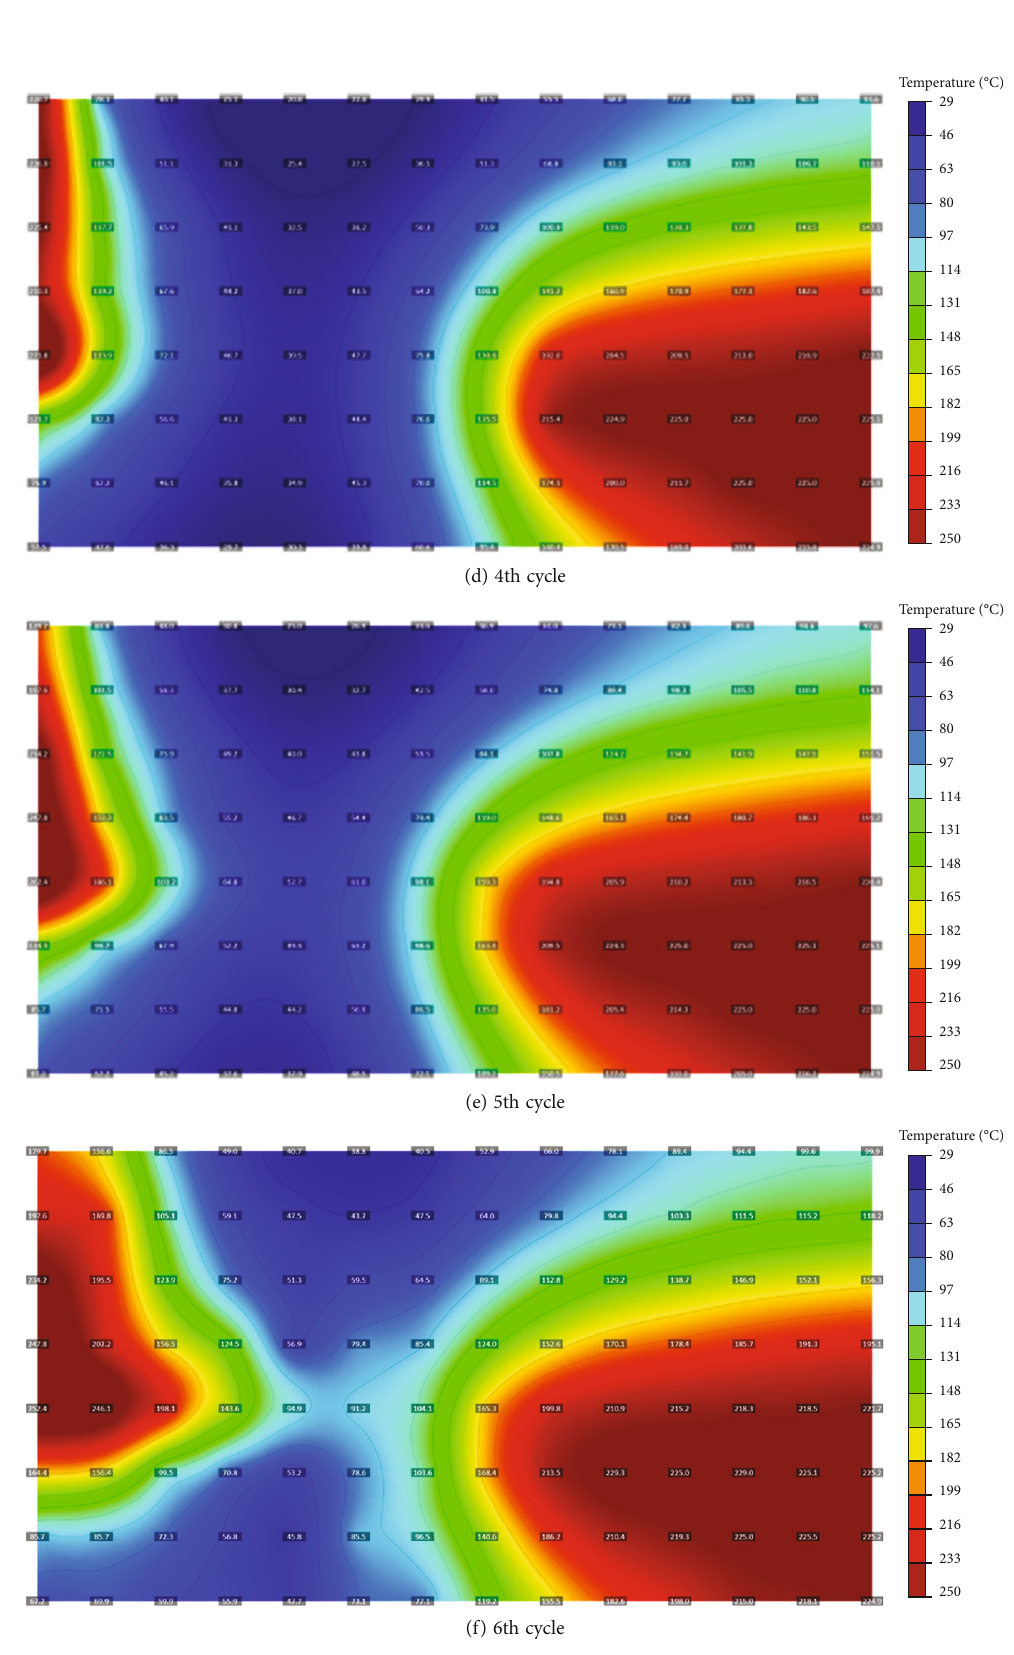
Figure 8: Temperature distribution of di ff erent cycles of in fi lled conventional